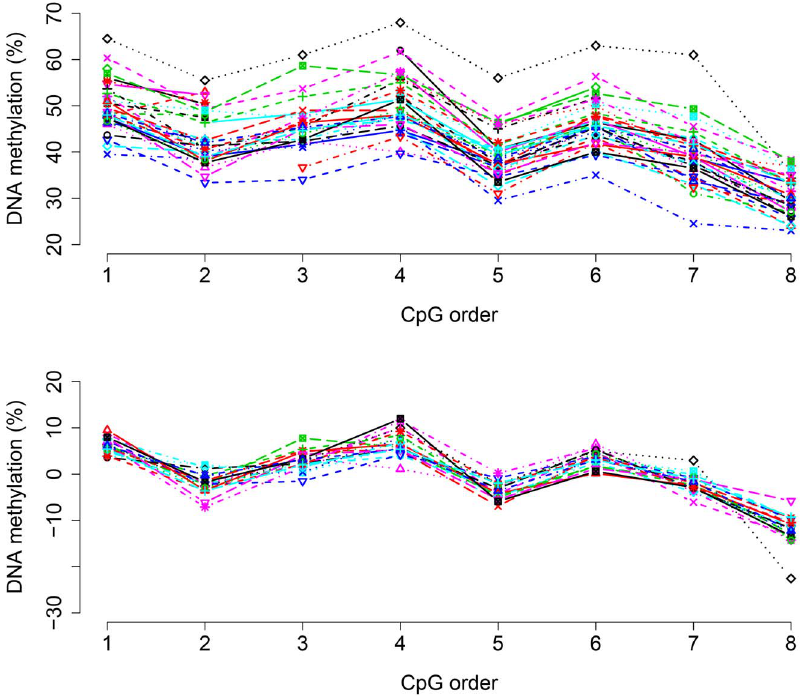
Figure 1. Methylation of the Crcp gene in the trigeminal ganglion. Methylation of each studied CpG of the promoter region of the Crcp gene is shown without correction for rat levels (upper panel) and with correction for rat levels (lower